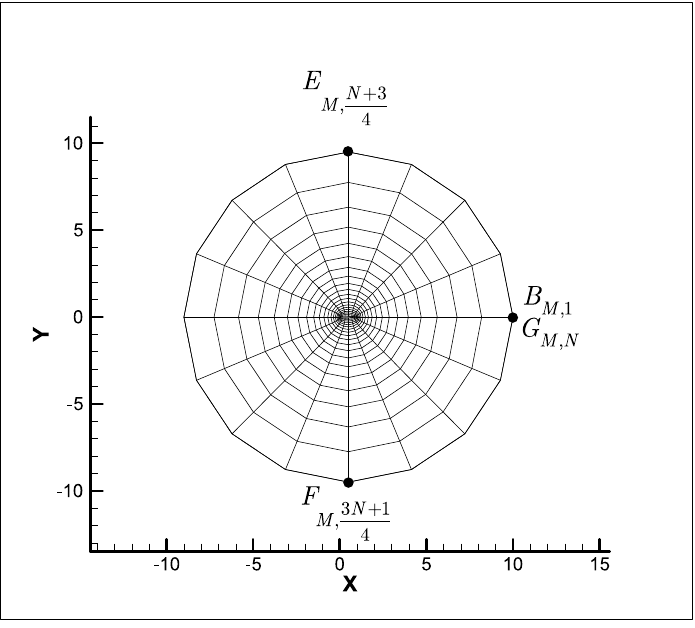
Figure 6. Representation of node number of top and bottom points on the outer boundary (far-field).